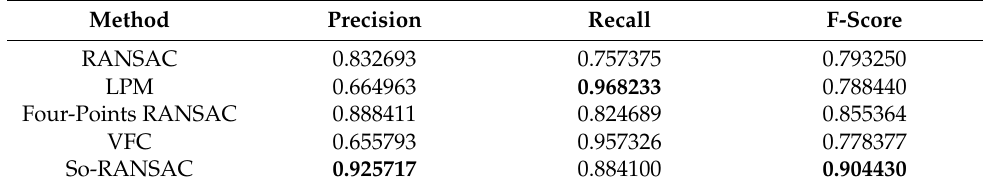
Figure 9. F-score of each method in the five sets of experimental data: ( a ) line chart and ( b ) histogram. Table 4. Performance comparison.